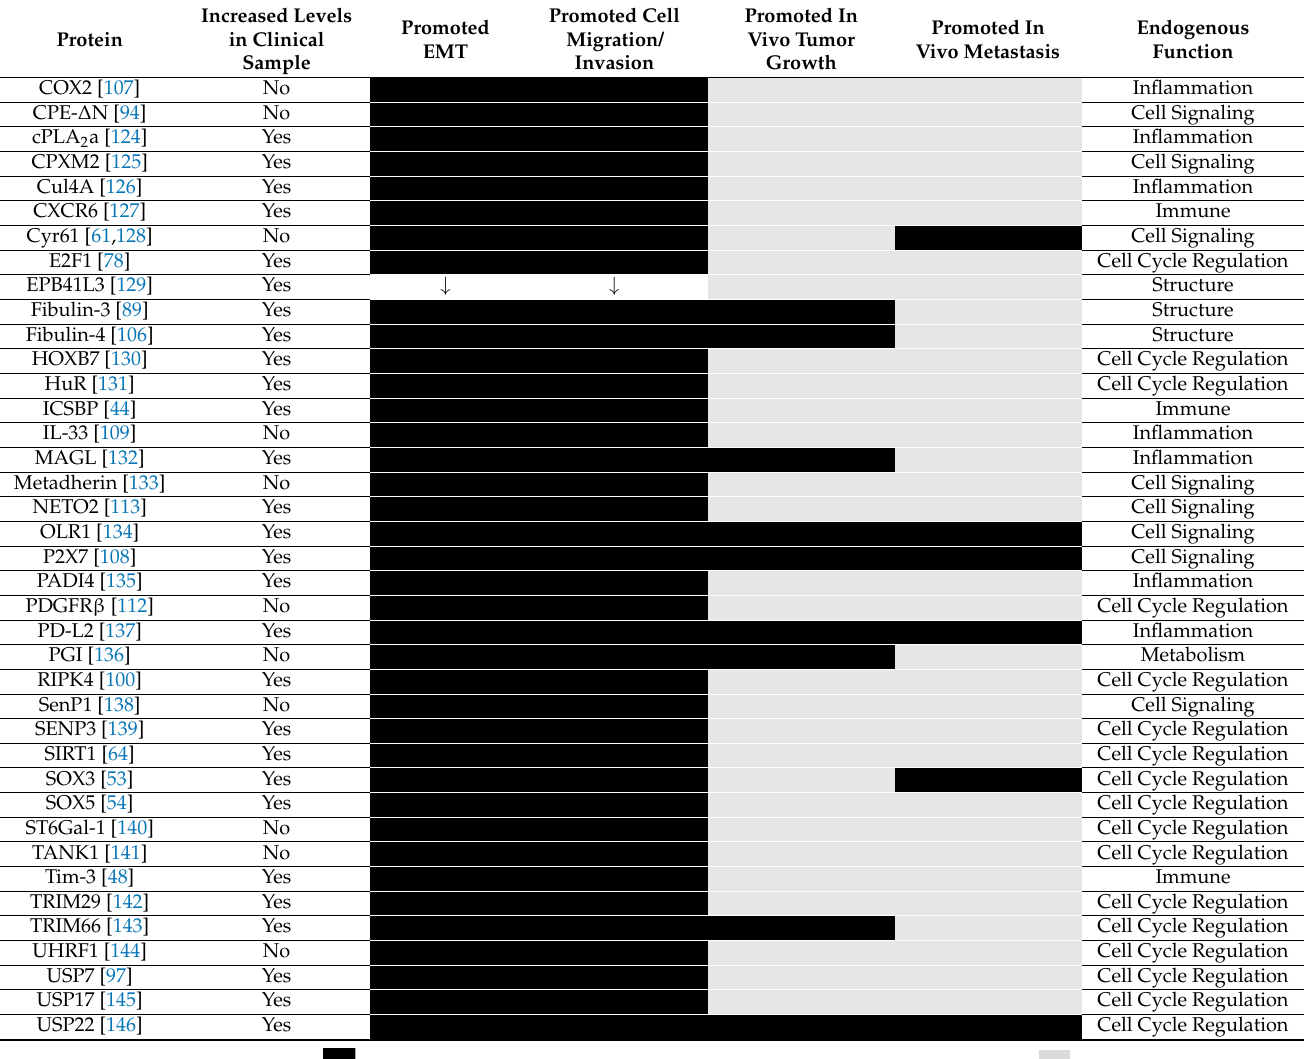
Table 2. Effects of poorly expressed proteins in OS.